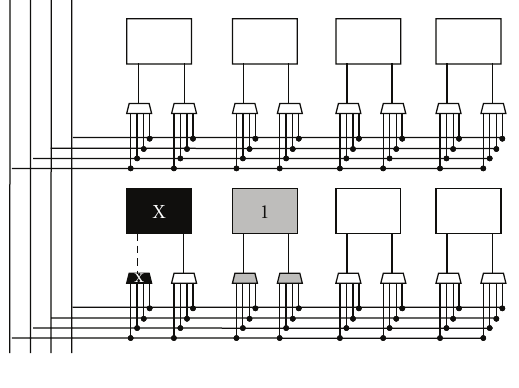
Figure 9: Example of a defective output multiplexer—the defective output multiplexer invalidates the data in the respective context